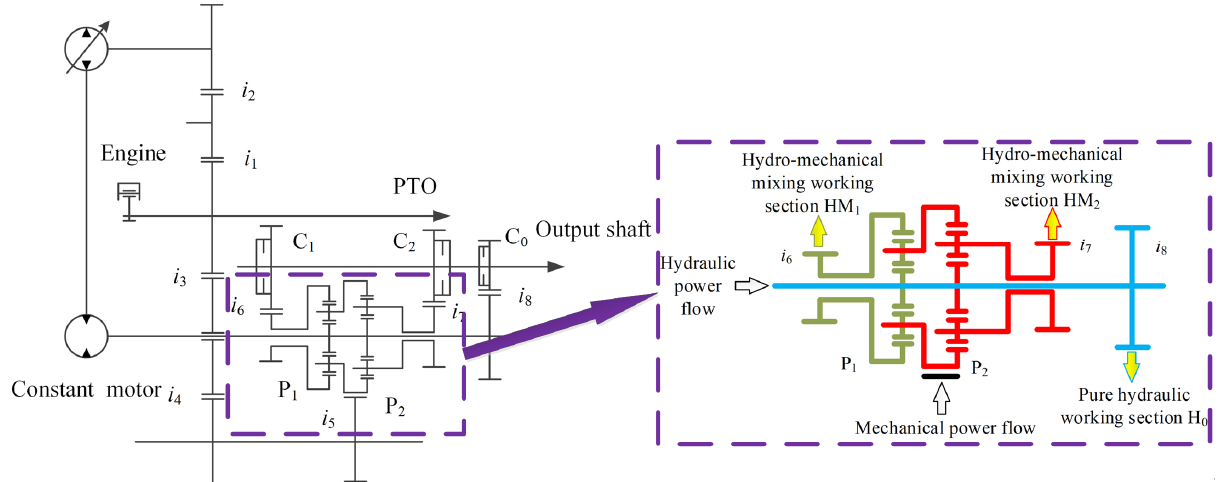
Figure 1. Transmission scheme of HMCVT for tractor researched in the paper.